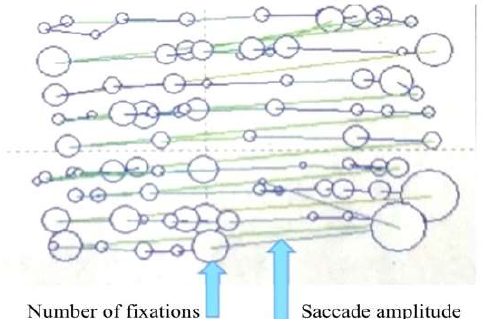
Figure 4. Schematic diagram of a fixation trajectory map.